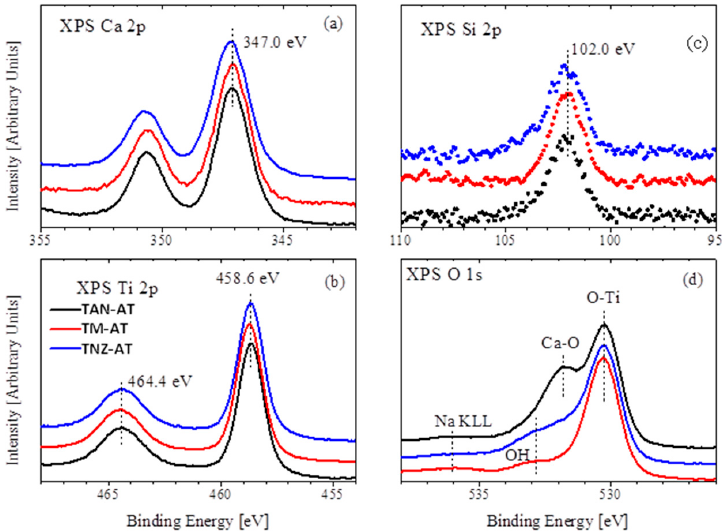
Figure 7. XPS (X-ray photoelectron spectroscopy) Ca 2p ( a ), Ti 2p ( b ), Si 2p ( c ) and O 1s ( d ) of treated Ti-alloys.